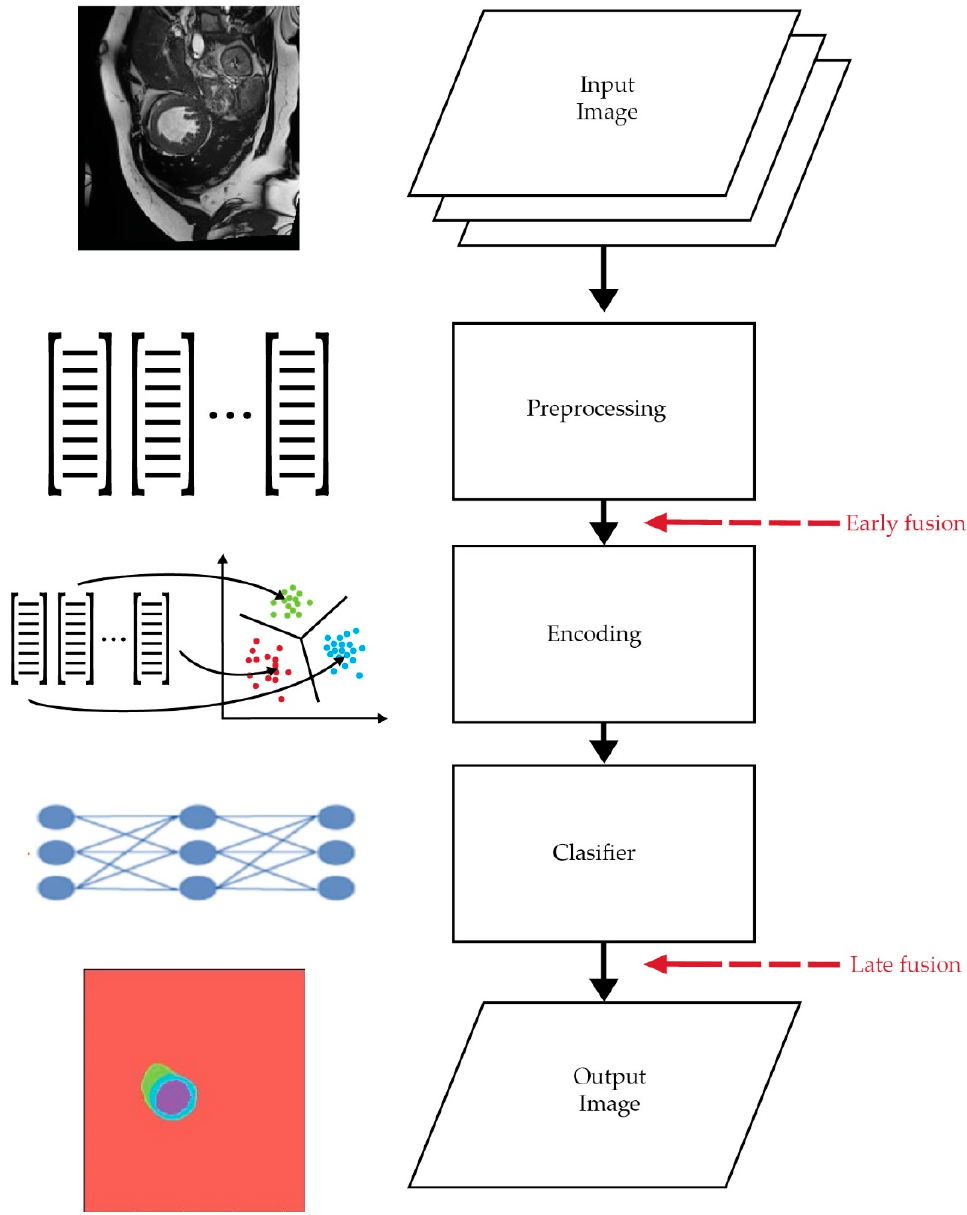
Figure 7. In early fusion, all local attributes (shapes and colors) are retrieved from identical regions and locally concatenated before encoding. In late fusion, image representations are derived inde- pendently for each attribute and concatenated